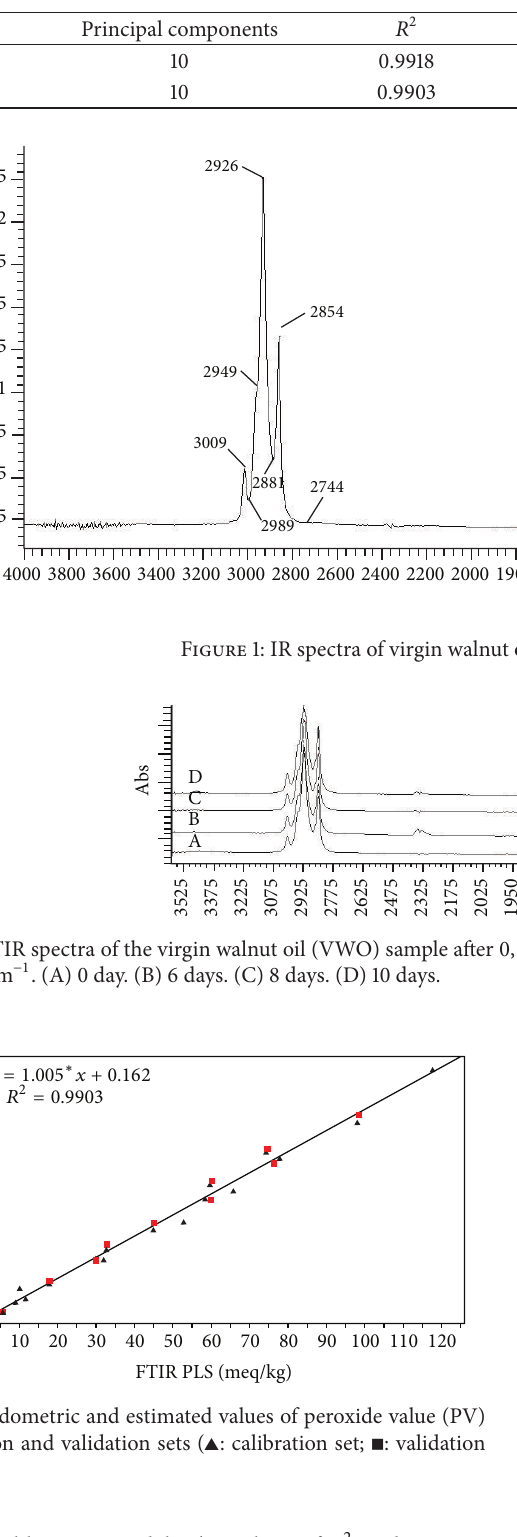
Table 2: PLS performance for analysis of calibration and validation model.